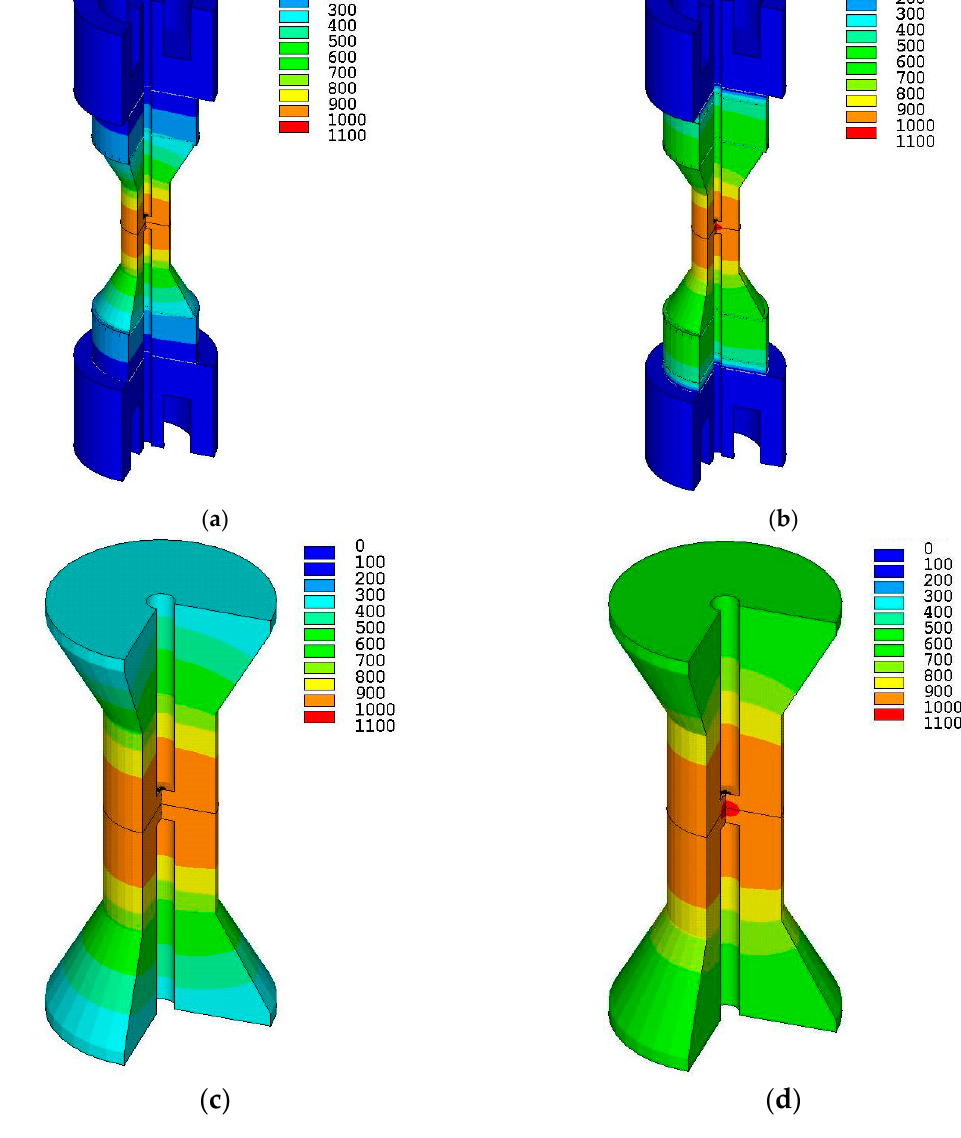
Figure 5. Modeled temperature distribution (°C) at 1200 s (holding stage): ( a,b ) in entire setup and ( c,d ) in dummy. Left—regular setup, right—setup with CFRC plates.